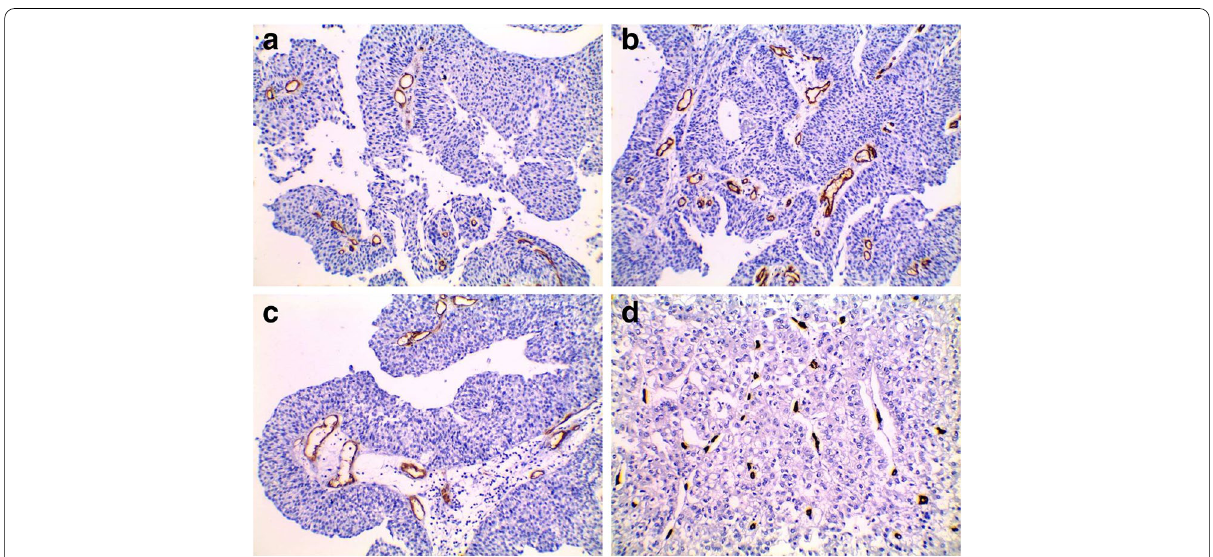
Fig. 3 CD34 labeled intratumor micro blood vessels (